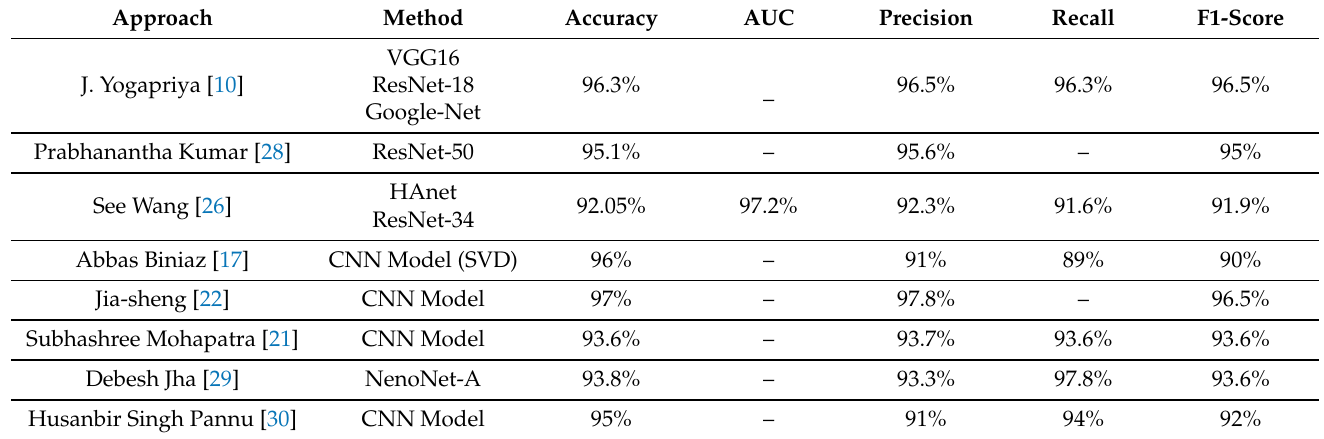
Table 1. A literature review of related studies on WCE image